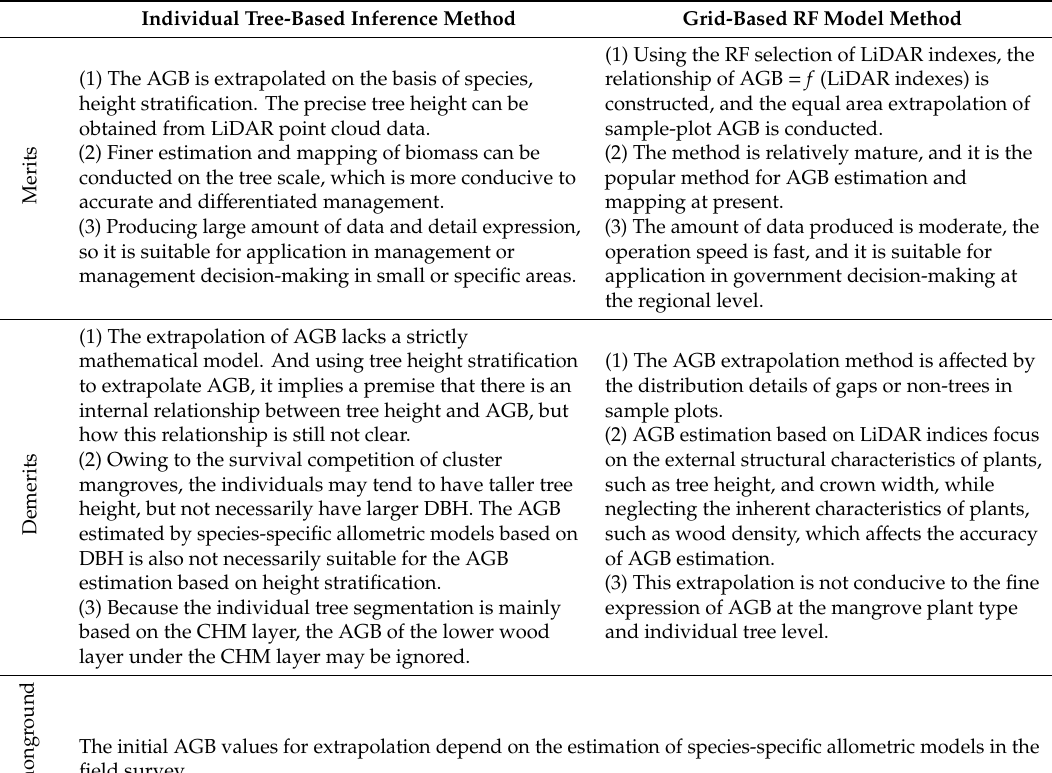
Comparison of the individual tree-based inference method and the grid-based RF model